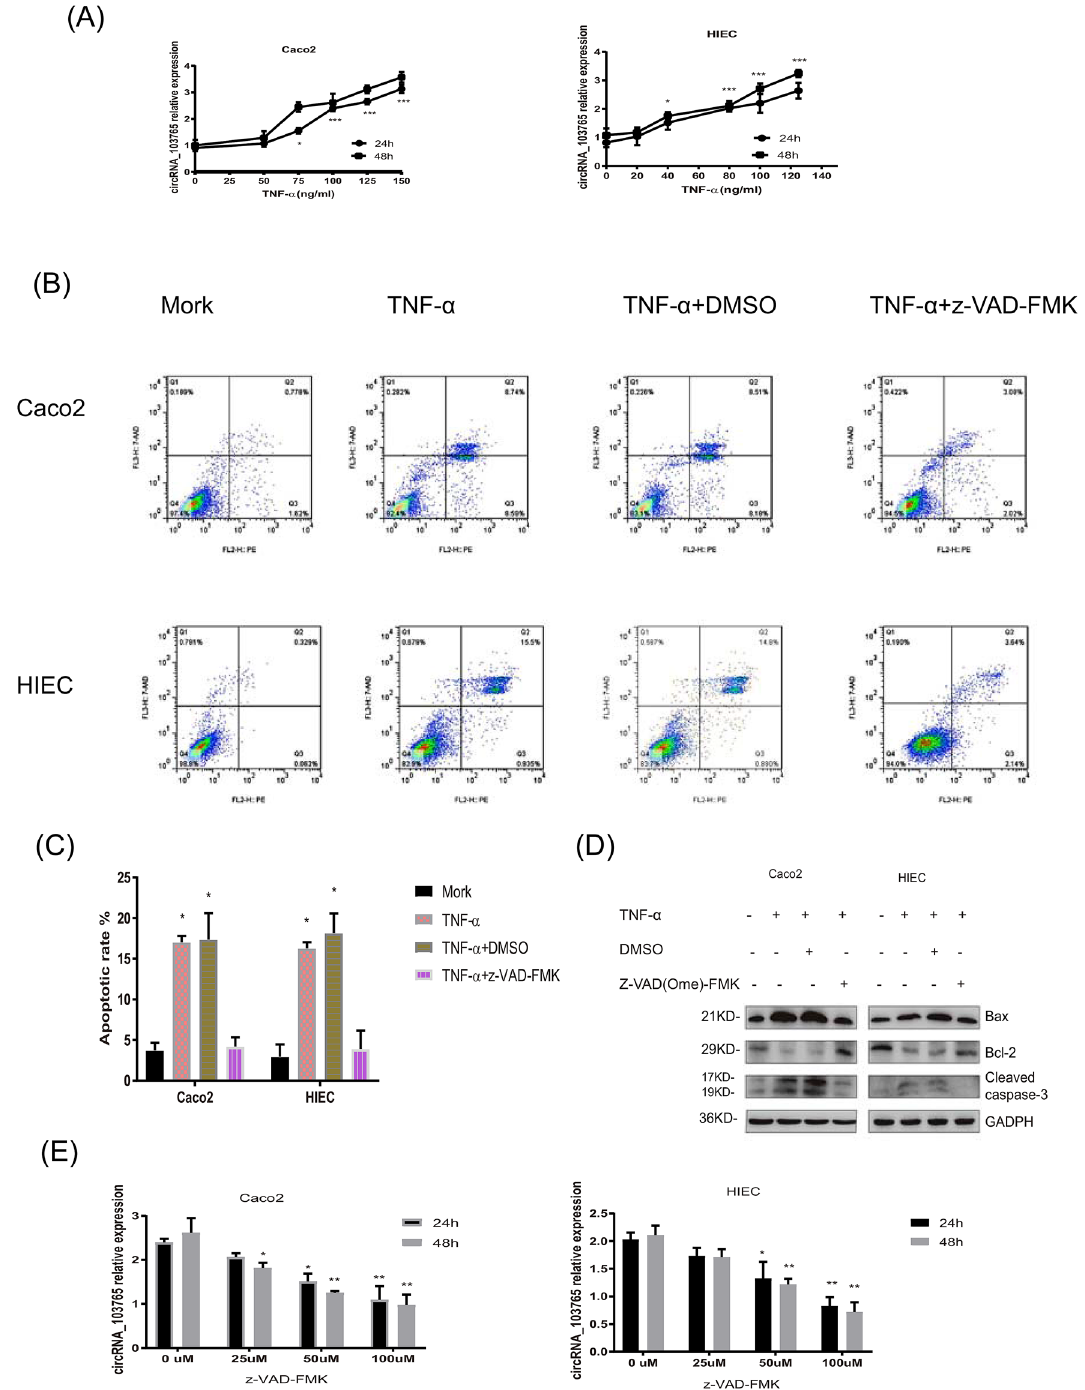
Figure 3. TNF-α induces circRNA_103765 transcription through promoting cell apoptosis in the human intestinal epithelial cell line. ( A ) qRT-PCR analysis of circRNA_103765 expression in Caco2 and HIEC cells treated with TNF-α for 24 h and 48 h. ( B , C ) Apoptosis rate was analysed by flow cytometry after treated with TNF-α and z-VAD-FMK. ( D ) The expression levels of apoptosis-related proteins were determined by western blot. ( E ) Effect of various concentrations of z-VAD-FMK on circRNA_103765 expression. Caco2 and HIEC cells were stimulated with TNF-α (100 ng/mL TNF-α for Caco2, 80 ng/mL for HIEC) in the presence of various concentrations of z-VAD-FMK. The level of circRNA_103765 was measured after 24 and 48 h by qRT-PCR. *p < 0.05, **p <